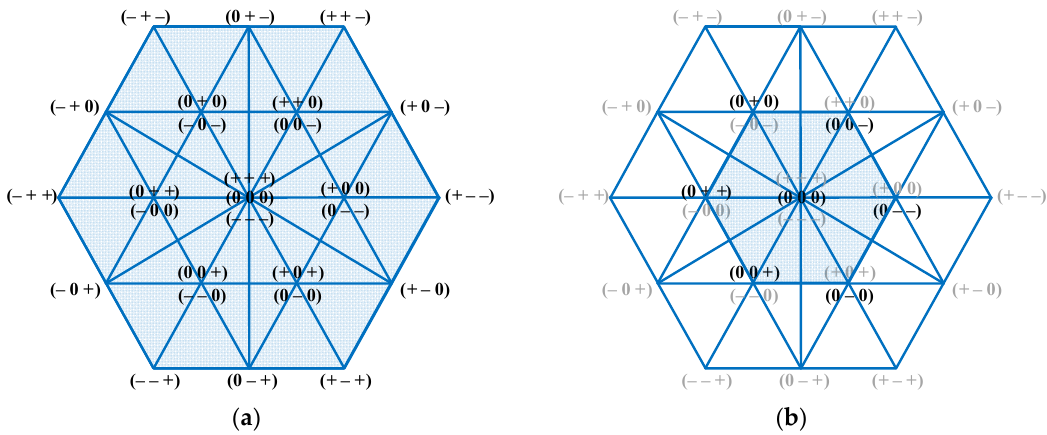
Figure 4. Vector diagram of HANPC converters under ( a ) healthy conditions ( b ) faulty conditions.